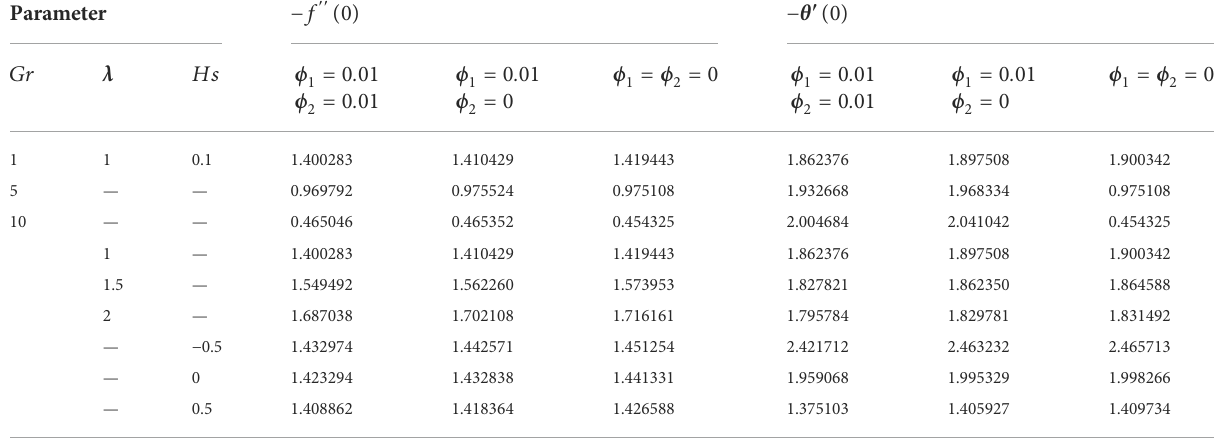
TABLE 3 Change in f 99 ( 0 ) and θ 9 ( 0 ) for various parameters in the cone when Sc (cid:3) 0 . 8 , Kc (cid:3) Ks (cid:3) 0 . 1. Parameter